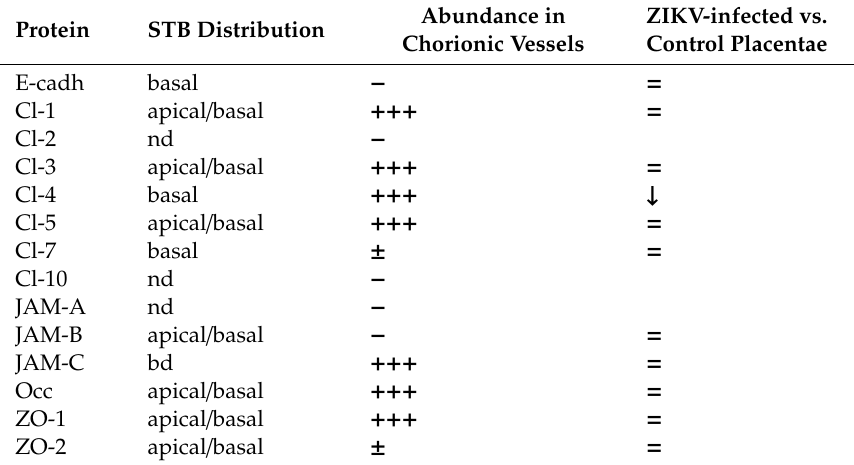
Table 3. Expression of E-cadherin and TJ proteins in the trophoblast of placental chorionic villi derived from control and ZIKV-infected women.